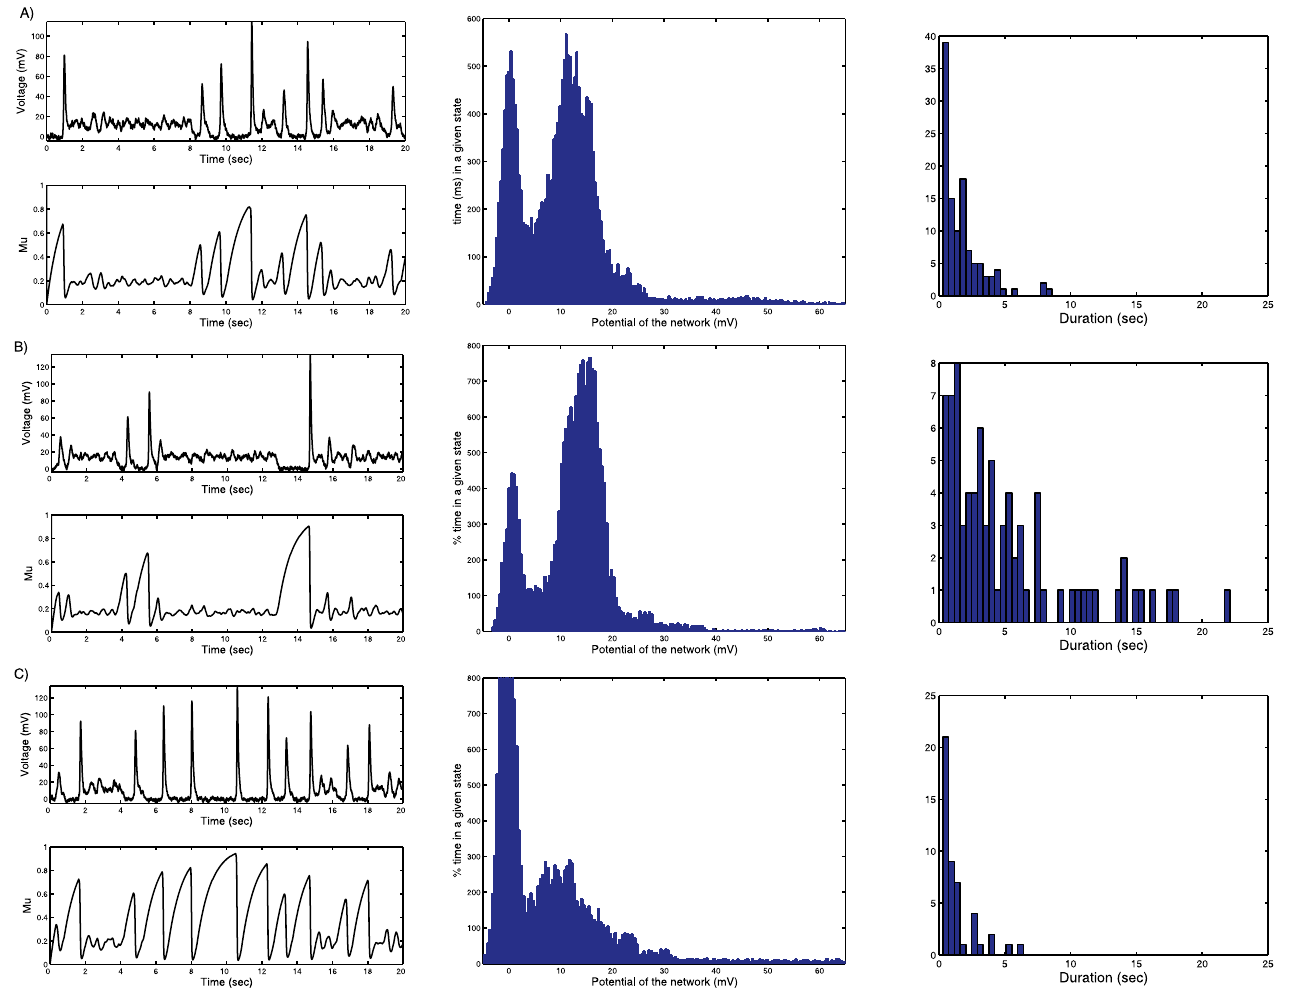
Figure 2. Up–Down State Dynamics under Normal and Clamp Conditions (A) A typical realization of Up–Down transition dynamics in the stochastic model with w T ¼ 12.6. Top graph: (Up) average population voltage (mV), baseline at 0 mV; (Down) plot of the depression variable l as a function of time: when the system arrives in the Down state, it is depressed. Then the depression recovers slowly toward 1. Usually the noise is able to produce a transition, before full recovery is achieved. Bottom graph: Histogram of the population voltage: fraction of the time spent in a given state. Units are in ms on the y -axis and in mV on the x -axis: the fraction of total time spent in the Up and Down state is about the same during the 20 s of simulations. The maximum time in the Up state is about 500 ms but the mean maximum time is about 3 s. Right column graph of (A): histogram of the duration of the Up states. (B) Effect of an external stimulation: depolarization. When a constant external input (I ¼ 0.8) is added into the model, the neural network spends on average more time in the Up state than in Down state. In that case, the attractor point P 1 is shifted and is now closer to the separatrix. (C) Hyperpolarization, simulated by a current injection . A hyperpolarization (I ¼(cid:1) 0.3) drives the ensemble of neurons at a lower mean potential, and as a result the neural network spends on average more time in the Down